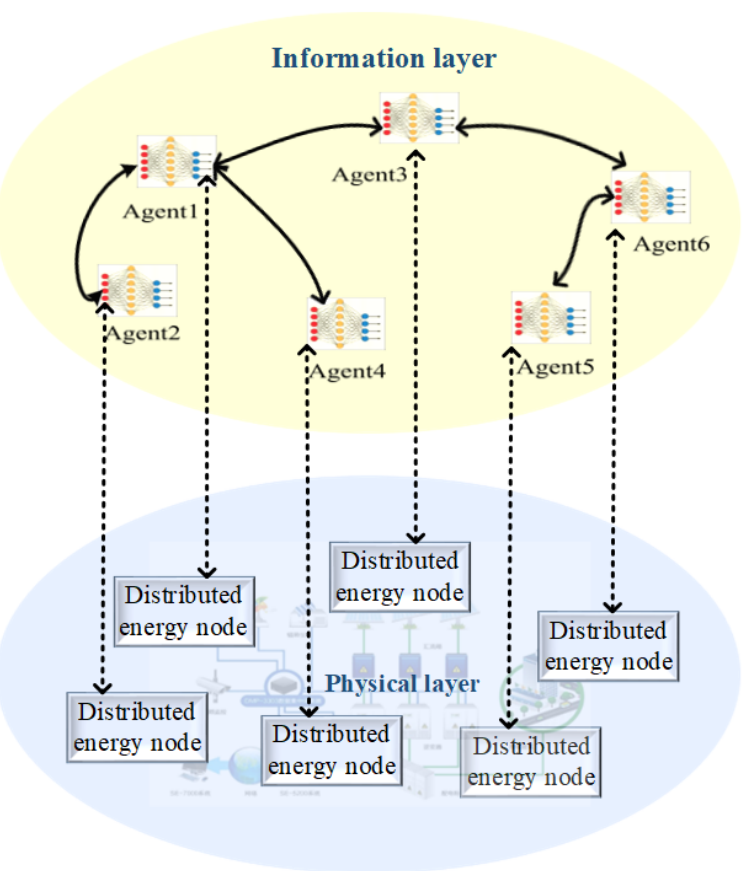
Figure 4. The topological structure of distributed energy